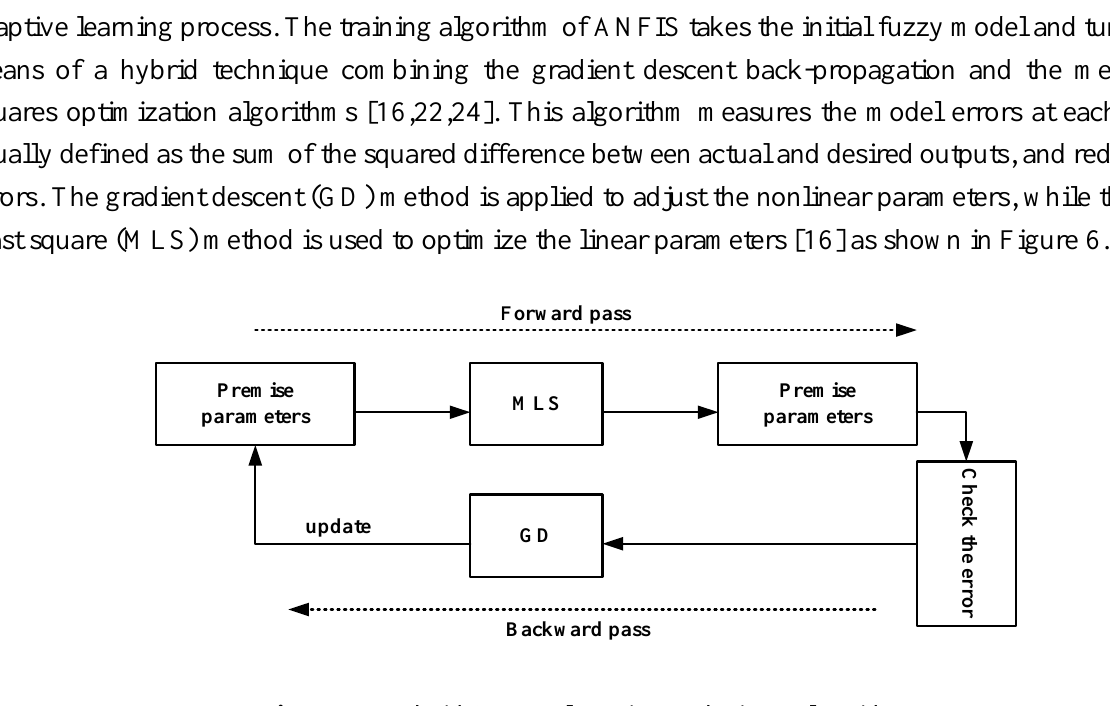
Figure 6. Hybrid ANFIS learning technique